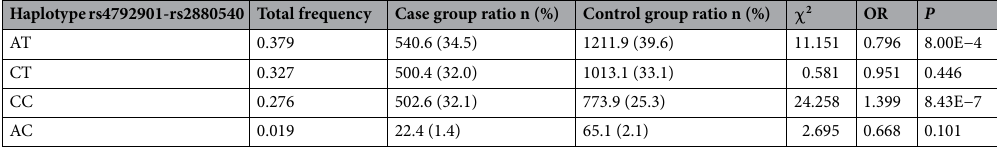
Table 3. Distribution of haplotypes consisting of rs4792901 and rs2880540 between the cases and controls. OR odds